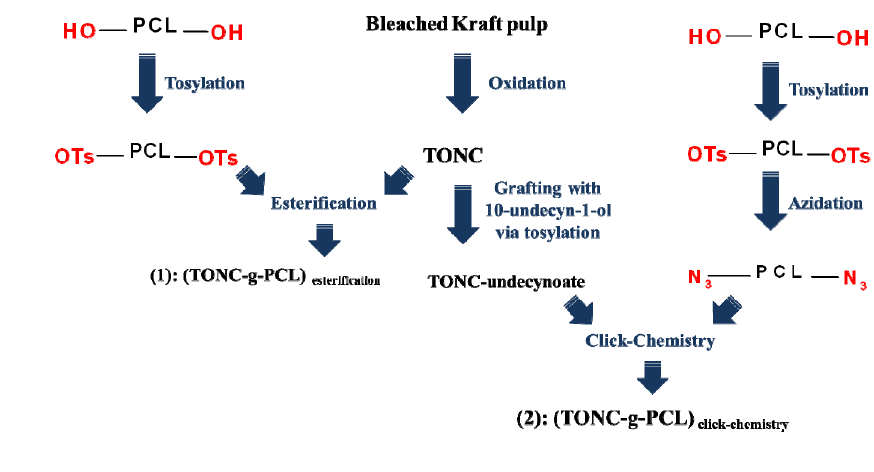
Figure 1. Strategy of TEMPO-oxidized nanocelluloses (TONC) modification adopted in this